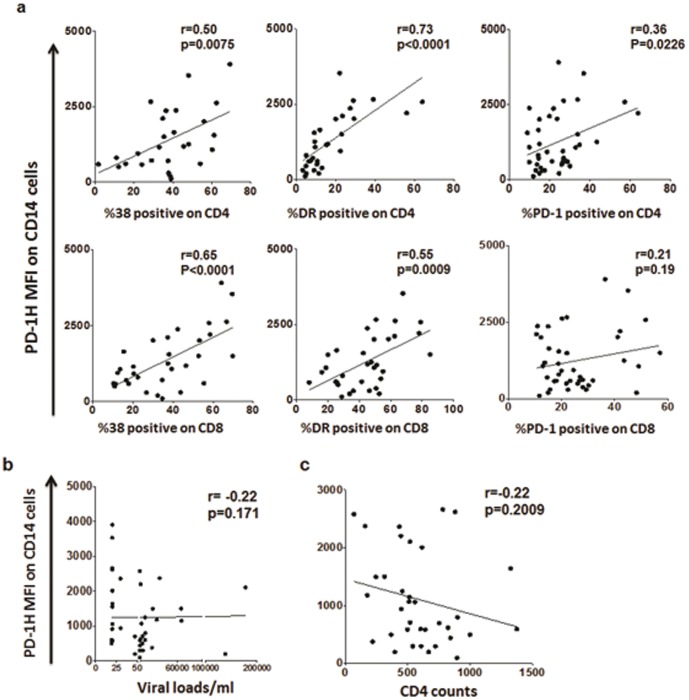
The level of PD-1H expression on monocytes in HIV-infected individuals correlates with immune activation and CD4 T cell depletion, but not viral load.Correlation of PD-1H expression on monocytes with (a) immune activation/exhaustion markers CD38, PD-1 and HLA-DR on CD4 and CD8 T cell subsets (b) viral loads and (c) CD4 counts. (n = 35). r and p values determined by Spearmans non parametric test values. p<0.05 were considered significant.